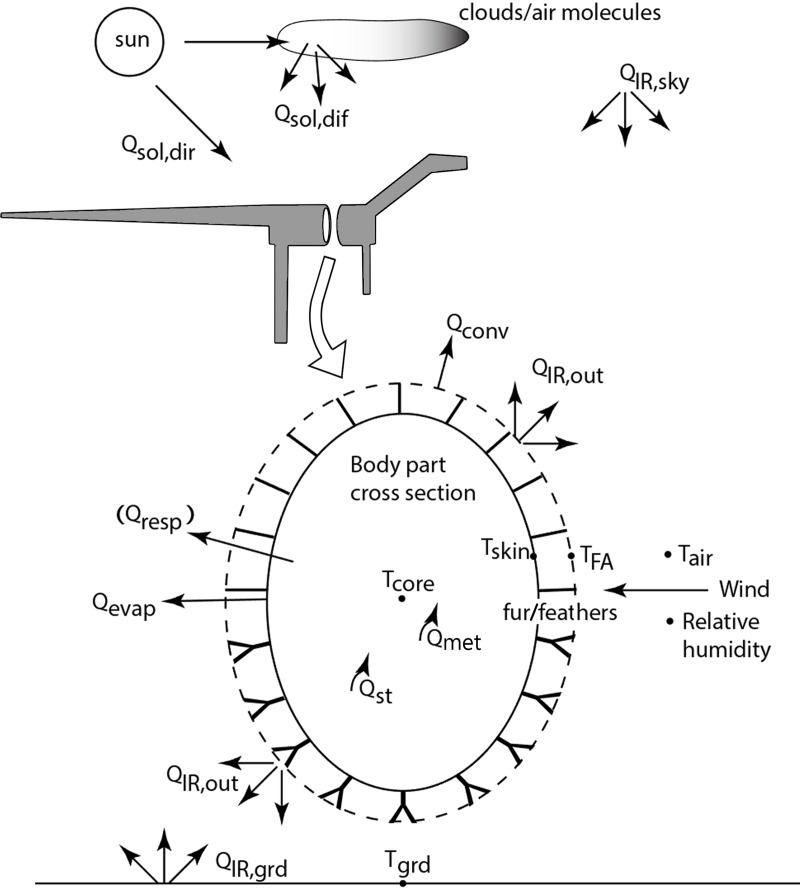
Heat transfer pathways between modeled organism and environment.Cross-section of a body segment (e.g., elliptical cylindrical torso of distributed heat generating flesh surrounded by an optional layer of fat (not shown), then skin surrounded by porous insulation whose properties may be the same or different dorsally vs. ventrally). The flesh is generating metabolic heat throughout the body (Qmet) and exchanging (Qresp, Qevap, QIRnet, Qconv, Qsol) heat with its environment as modeled by Niche Mapper (adapted from Porter et al. [23]). The transient model also includes a heat storage term, Qst, for the flesh. A full list of symbols and abbreviations can be found in the text.